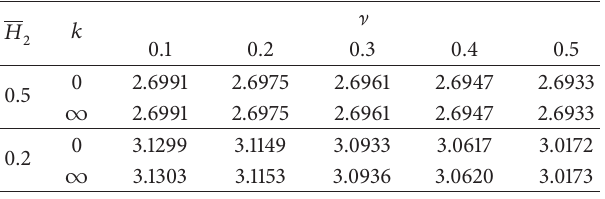
Table 4: Effect of Poisson ratio on the fundamental frequency parameter ( Ω ) of I:C-F beams with central and midplane delami- nation ( 𝐿/𝐻 1 = 10